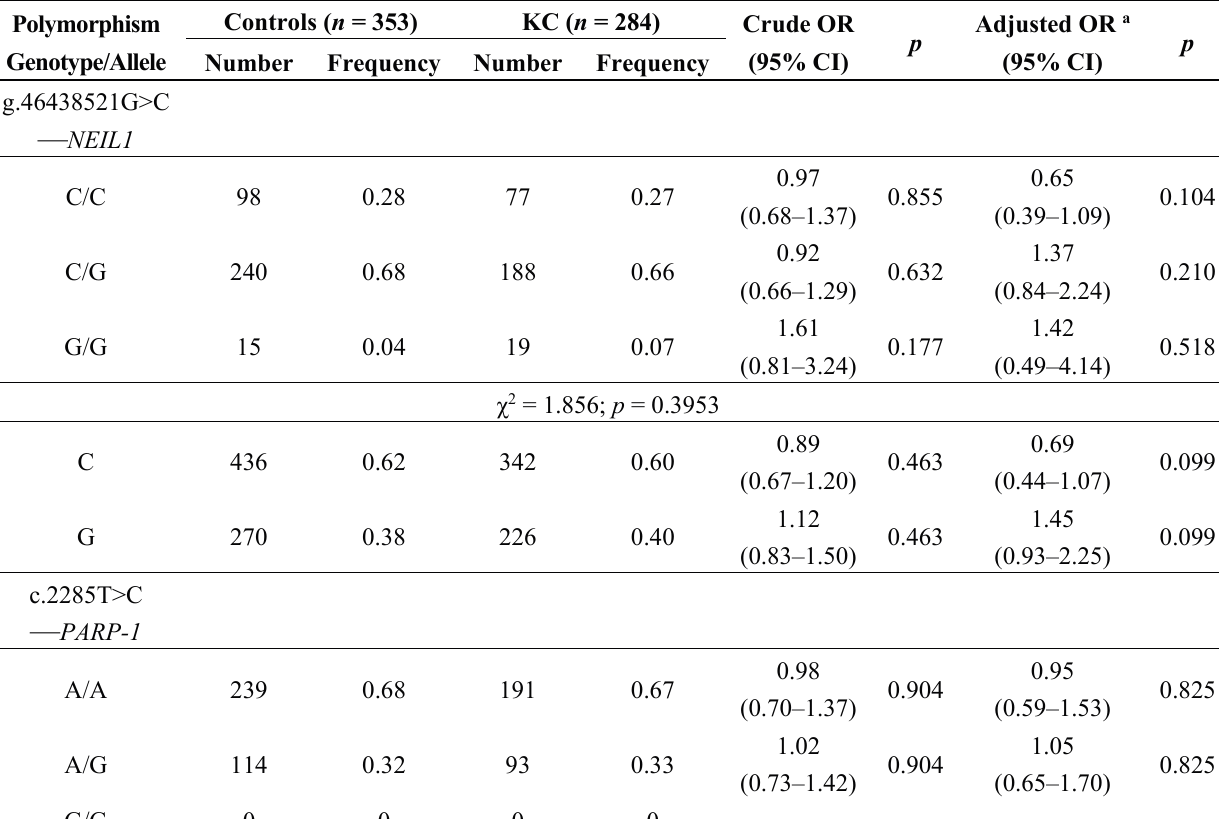
Table 2. Distribution of genotypes and alleles of the g.46438521G>C— NEIL1 ,